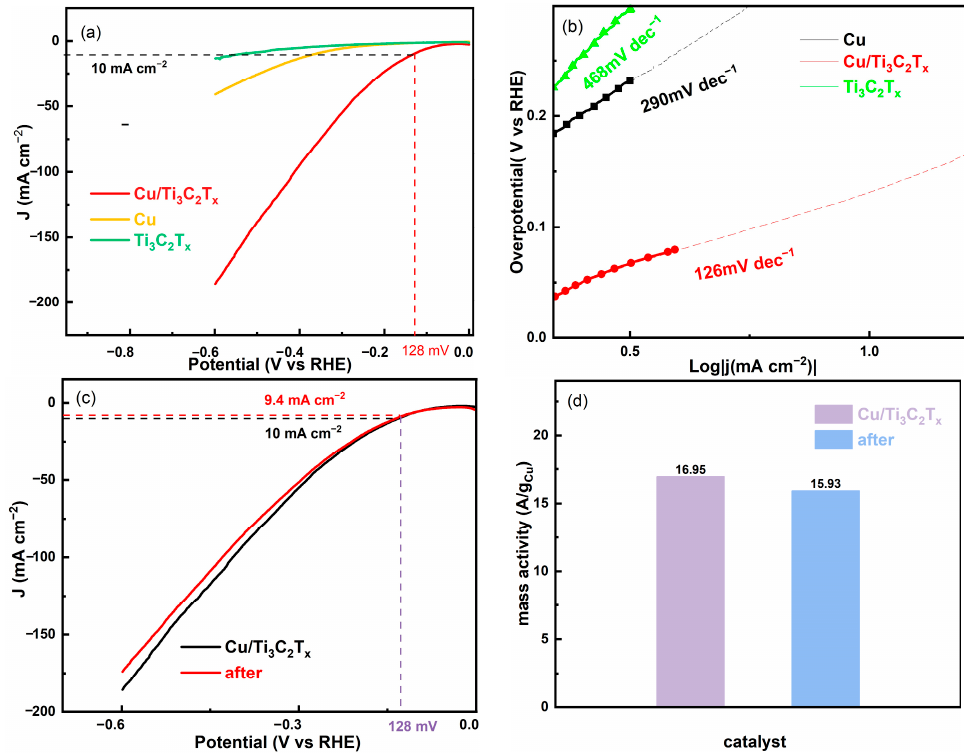
Figure 9. HER performance of Ti 3 C 2 T x , Cu and Cu/Ti 3 C 2 T x series catalysts: ( a ) LSV curves at the scan rate of 5mV s − 1 , ( b ) the corresponding Tafel plots, ( c ) stability test chart of Cu/Ti 3 C 2 T x , ( d ) comparisons of mass activity of Cu/Ti 3 C 2 T x.